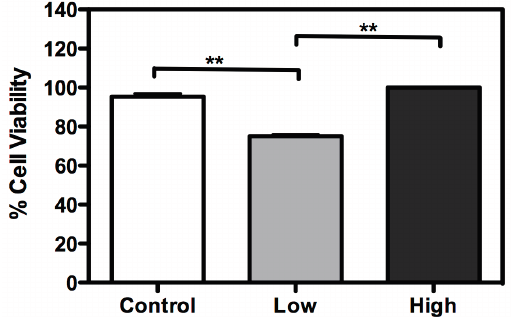
Figure 4. Membrane integrity is unaffected in BME26 cells after glucose treatment. The